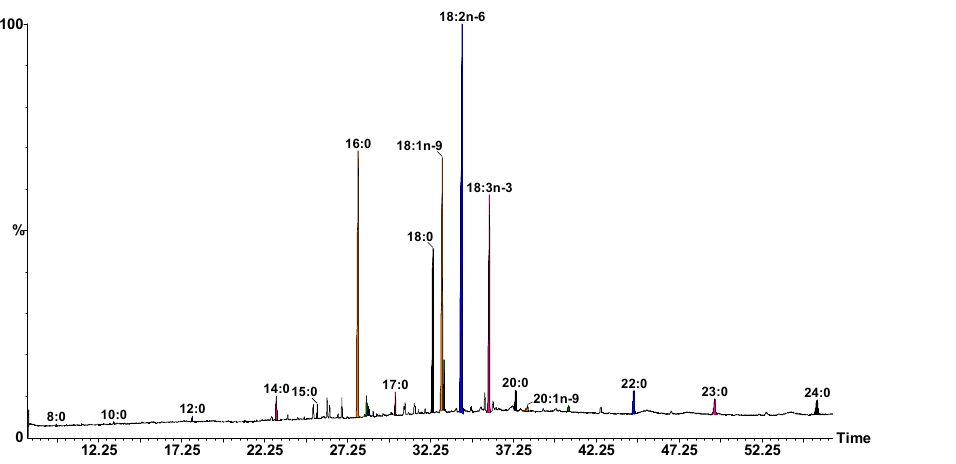
Figure 3. Fatty acid profile of ASTRA roots determined by GC-MS. Table 2. Fatty acid composition of the ASTRA